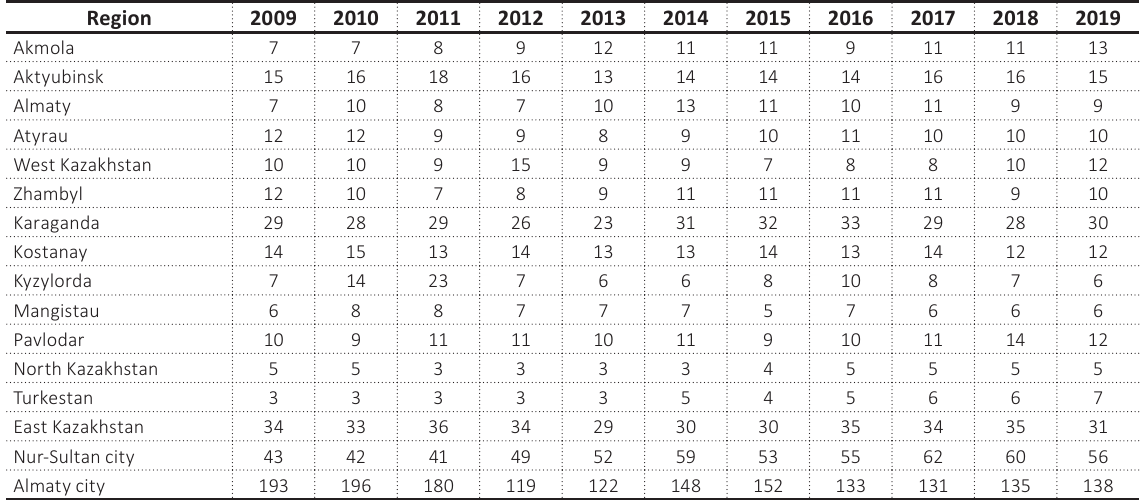
Table 5. The number of enterprises engaged in R&D for 2009–2019